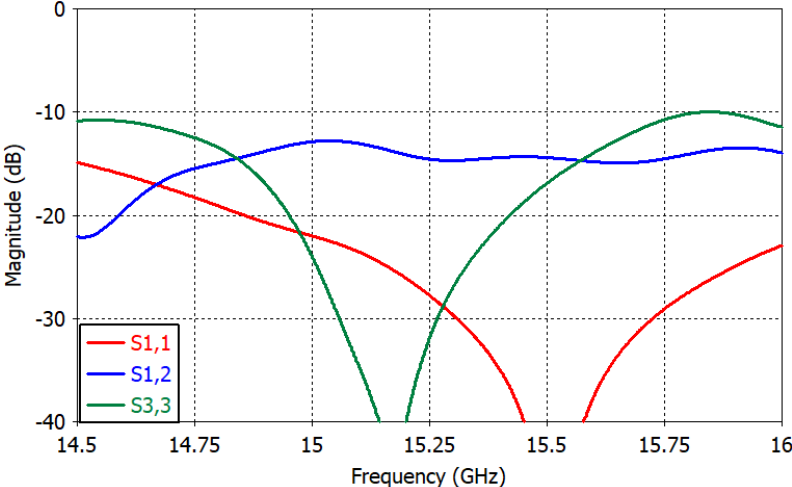
Figure 14. Reflection and coupling coefficients of the feed illuminating the reflector antenna.